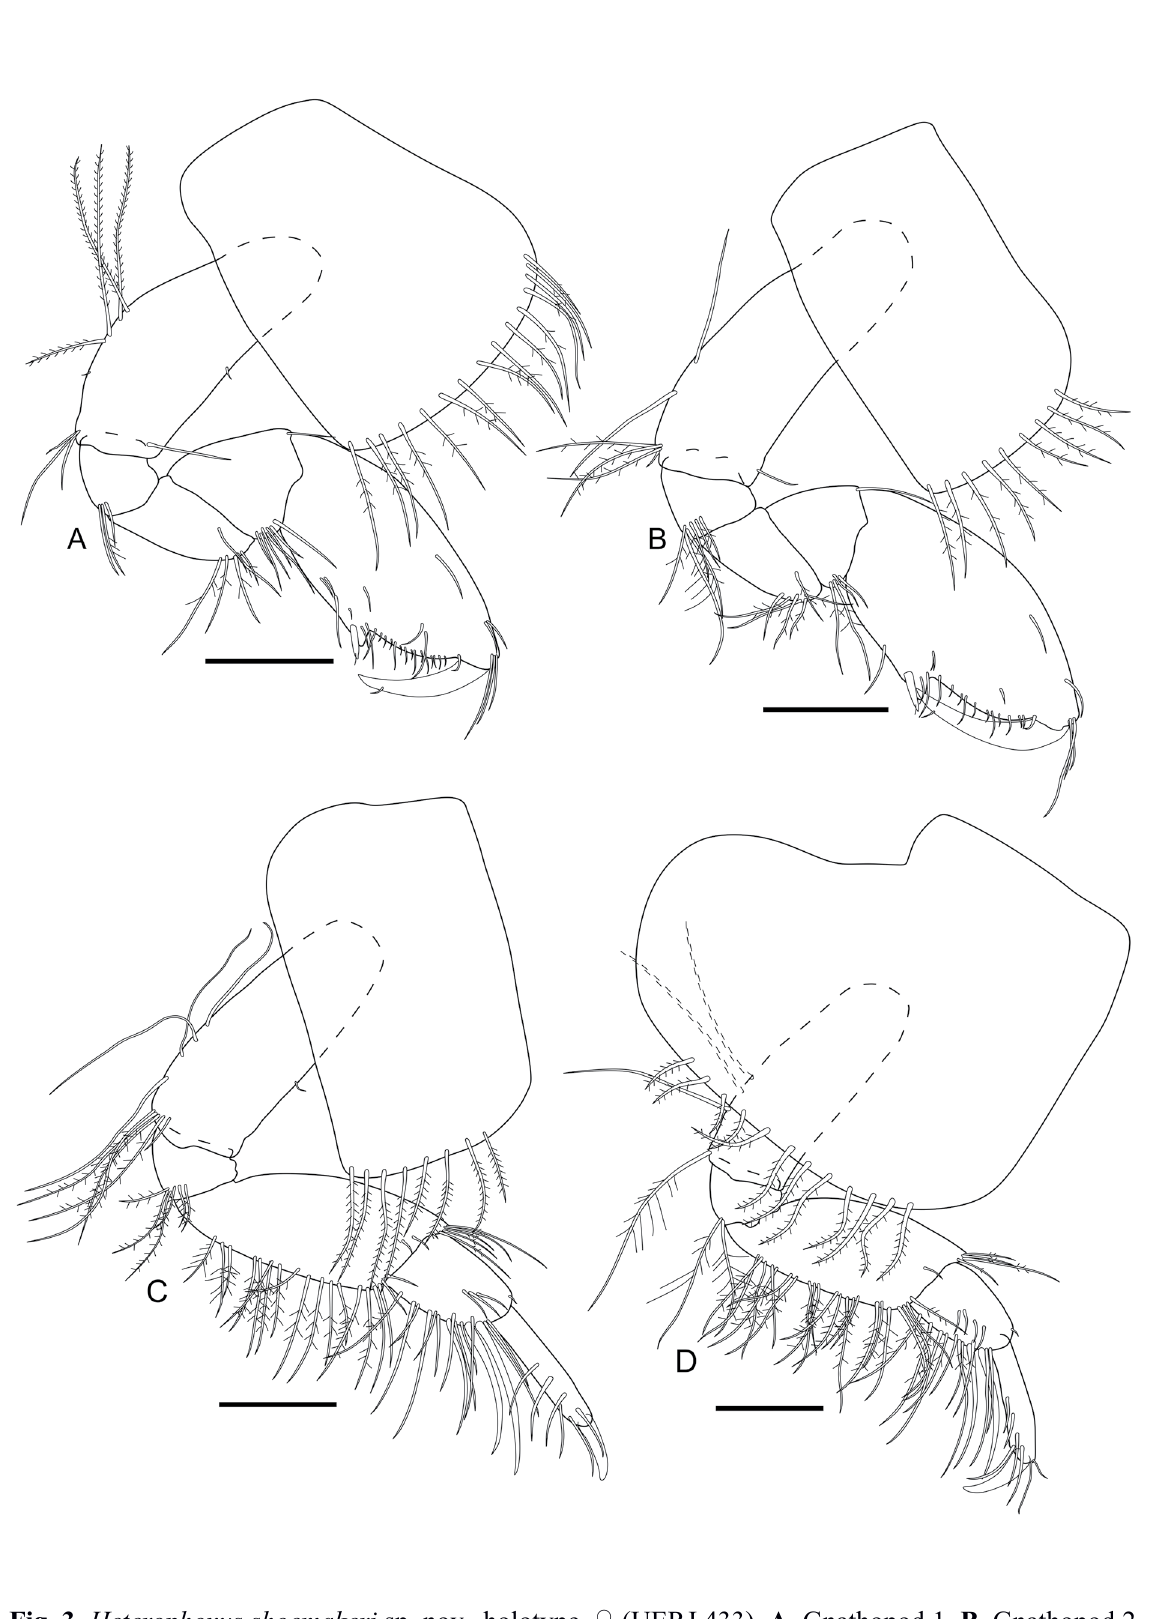
Fig. 3. Heterophoxus shoemakeri sp. nov., holotype, ♀ (UERJ 433). A . Gnathopod 1. B . Gnathopod 2. C . Pereopod 3. D . Pereopod 4. Scale bars = 0.2